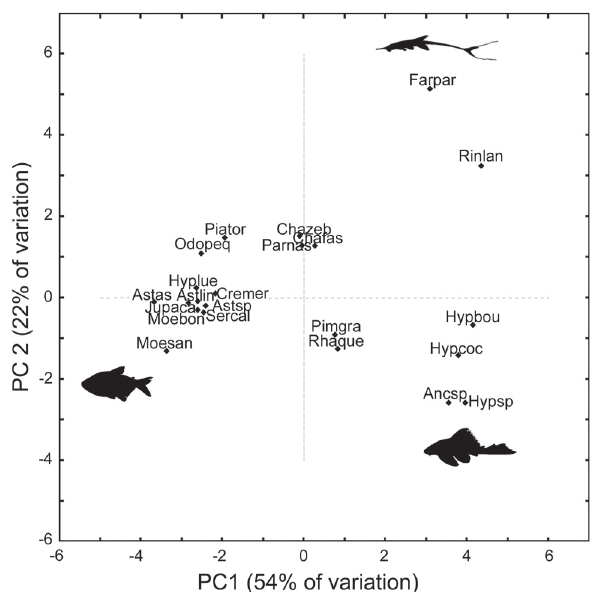
Fig. 2. Projection of the first two PCA axes based on 14 ecomorphological attributes for the following fish species from the upper Paraguai River, Brazil: Ancsp, Ancistrus sp.;